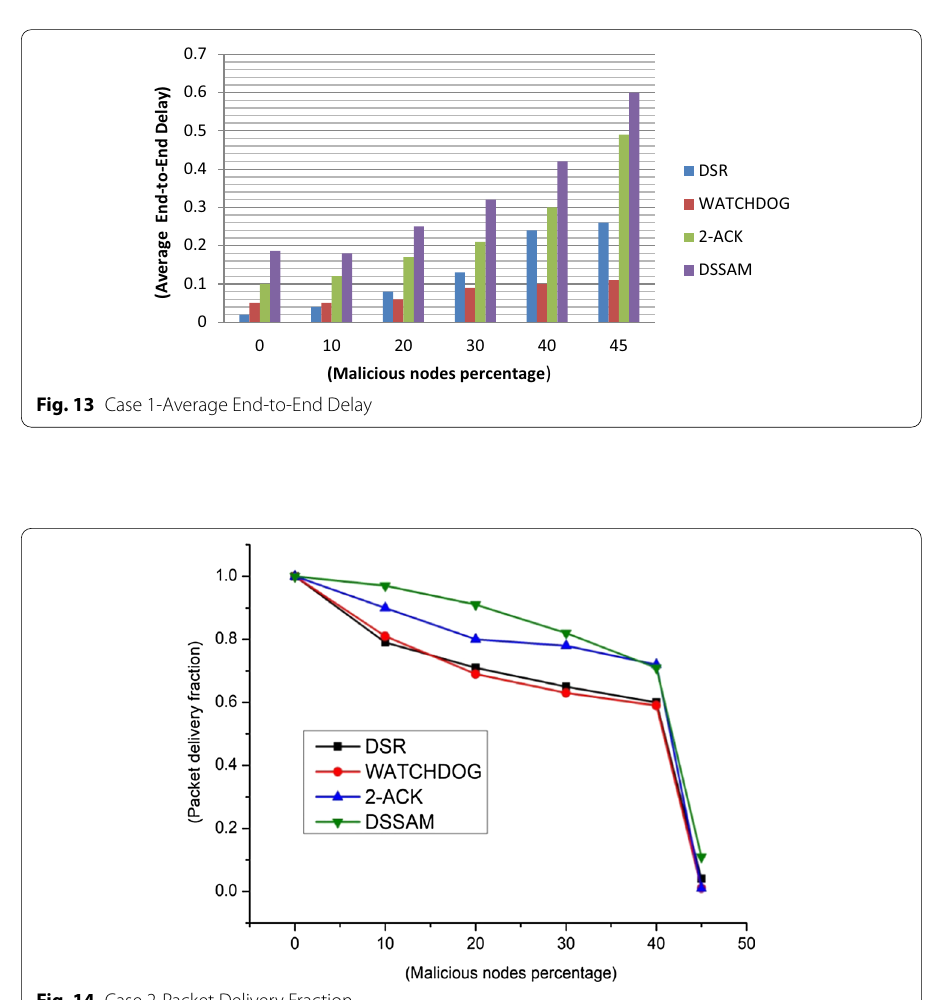
Fig. 14 Case 2-Packet Delivery